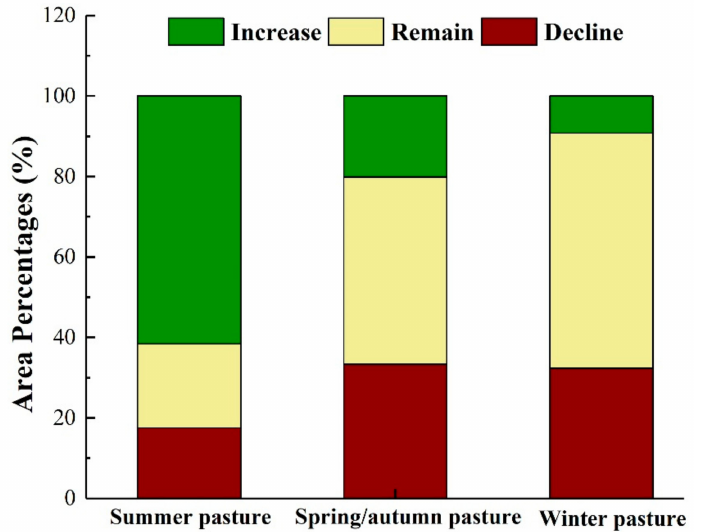
Figure 7. Probability statistics of variation of MODEI in different seasonal